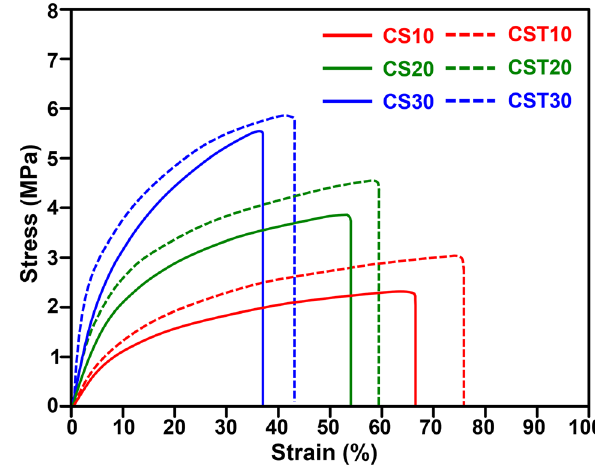
Figure 6: Stress – strain curves of the nano fi ber mats with and without T80